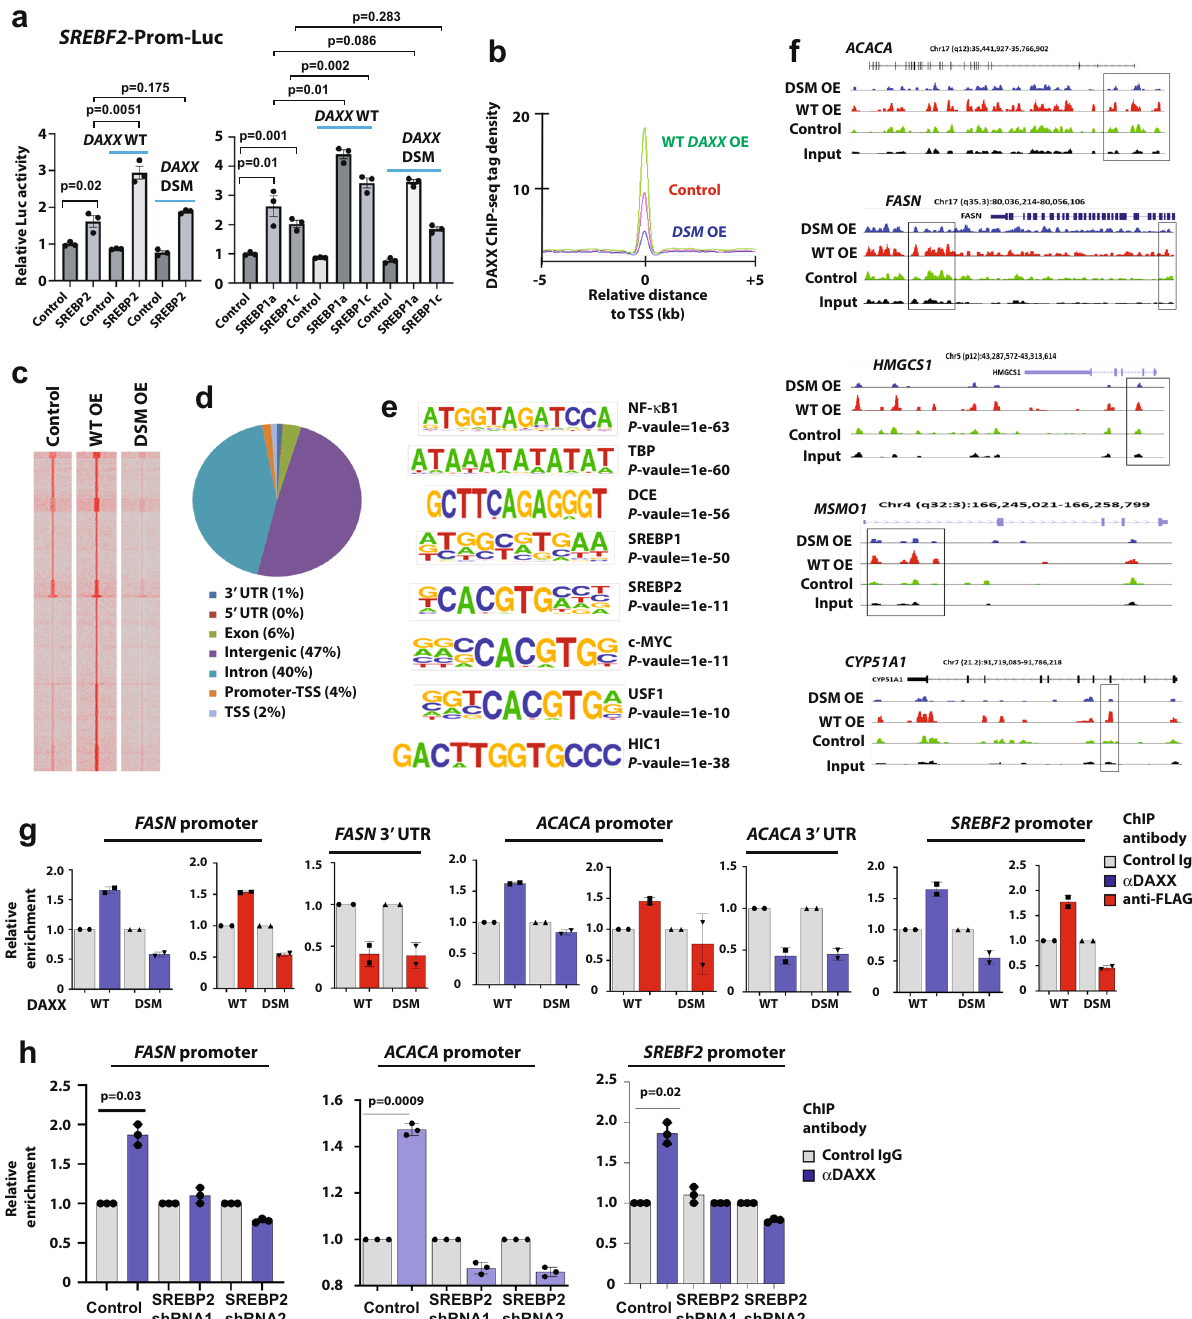
Fig. 4 | DAXX activates SREBP-mediated transcription and occupies the pro- motersoflipogenic genes. a MDA-MB-231 cellswere transfectedwith a luciferase reporter driven by a promoter fragment from the SREBF2 gene along with mature SREBP2, SREBP1a, SREBP1c, wt DAXX or the DSM mutant cDNA as indicated. Dual luciferase assays were done. Data are presented as mean values±SEM ( n =3 inde- pendent transfections). Luc: luciferase. b – f ChIP-seq analysis of genome-wide occupancyofDAXX. b , c ChIP-seqsignalintensityplot(acomparisonoftheaverage DAXX ChIP-seq tag intensities) and heatmaps in MDA-MB-231 control, WT OE, and DSM OE cell lines; signals are centralized to transcriptional start sites (TSS). d The genome-wide distribution of DAXX chromatin occupancy. e Motifs enriched as determined by the DAXX ChIP-seq dataset of MDA-MB-231 WT OE cells, and ( f ) occupancyof WT and the DSMmutant DAXX inselected lipogenicgenes based on ChIP-seqdata.Boxesinpanel f highlightregionsnearthe5 ’ endofeachgenealong with a region 3 ’ to the FASN gene with notabledifferences inpeakheights between